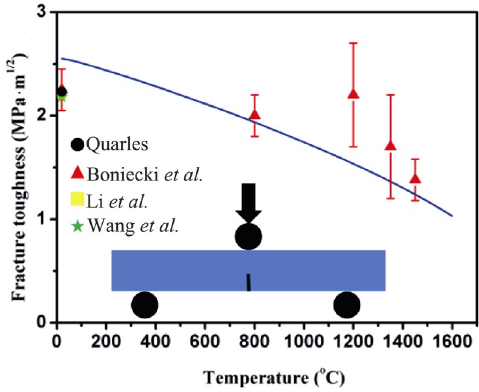
Fig. 9 Calculated and experimental values of fracture toughness of YAG transparent